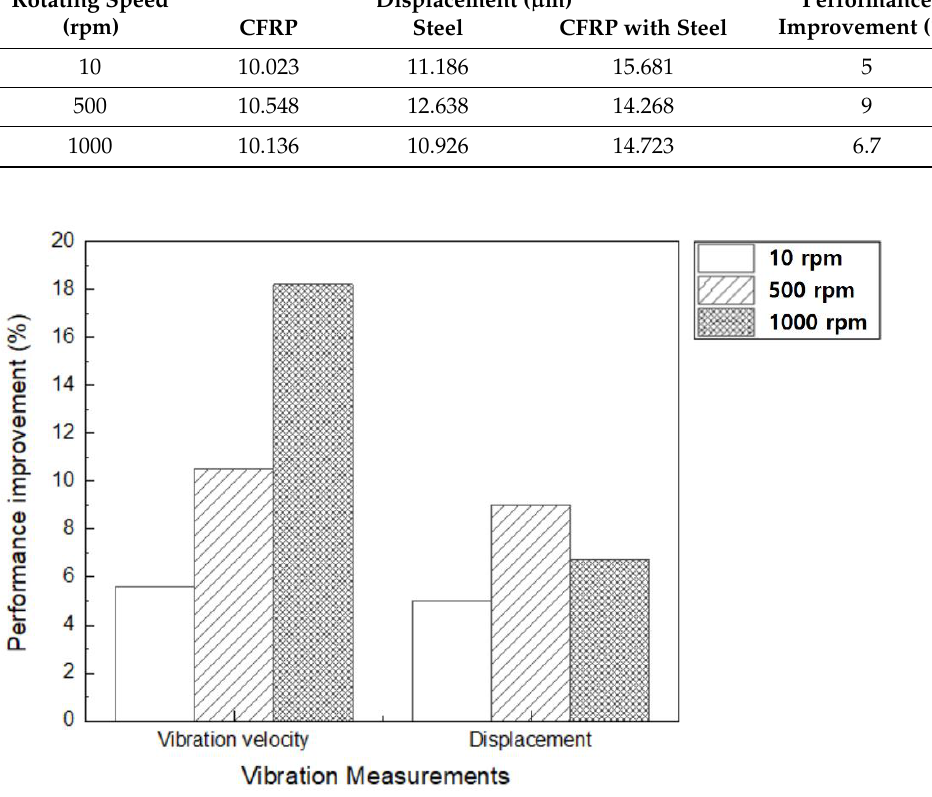
Figure 9. Performance improvement rate of the CFRP chuck adapter compared to steel in the bear- ing